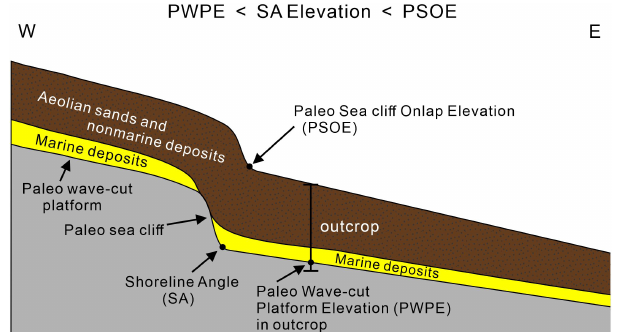
Figure 6. A schematic marine terrace commonly occurring along the eastern Korean Peninsula. Note that the shoreline angle (SA) elevation is between the paleo-wave-cut platform elevation (PWPE) measured in outcrop and the paleo-sea cliff onlap elevation (PSOE) measured in surface